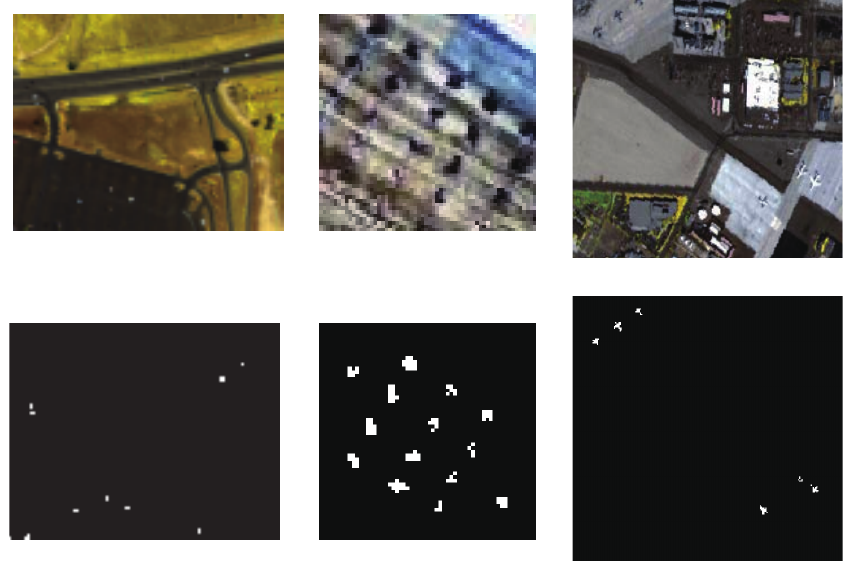
Figure 1. The visualization of the HSIs and the ground truth maps. The first row shows the false color pictures of Urban data set, AVIRIS1 data set, and AVIRIS2 data set respectively. The second row illustrates their corresponding ground truth